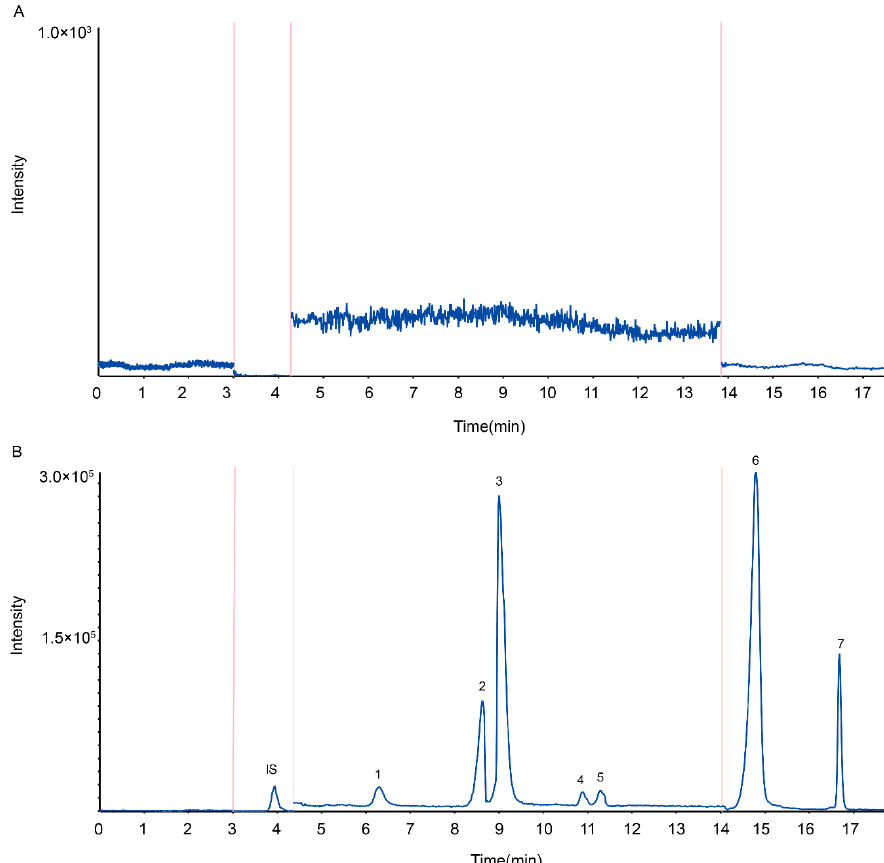
Figure 2. Chromatograms of the analytes and IS in positive ion mode. Note: ( A ) blank plasma; ( B ) sample plasma 1 h after administration of cocktail solution; (1) bupropion; (2) omeprazole; (3) phenacetin; (4) midazolam; (5) dextromethorphan; (6) chloroxazone; (7) diclofenac and IS.